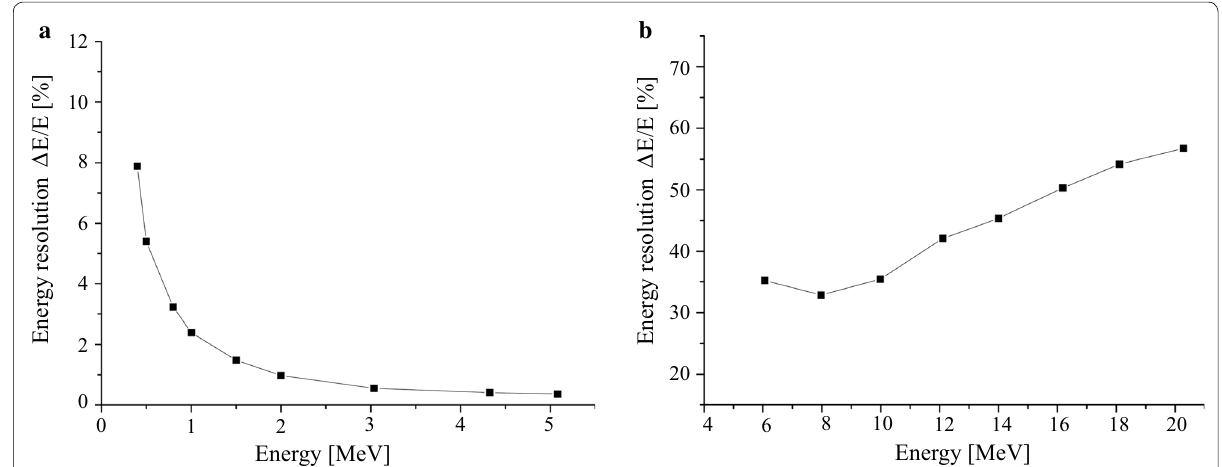
Fig. 4 The energy resolution estimated from the GEANT4 simulation results. a The energy resolution of the SSDs and b the energy resolution of the